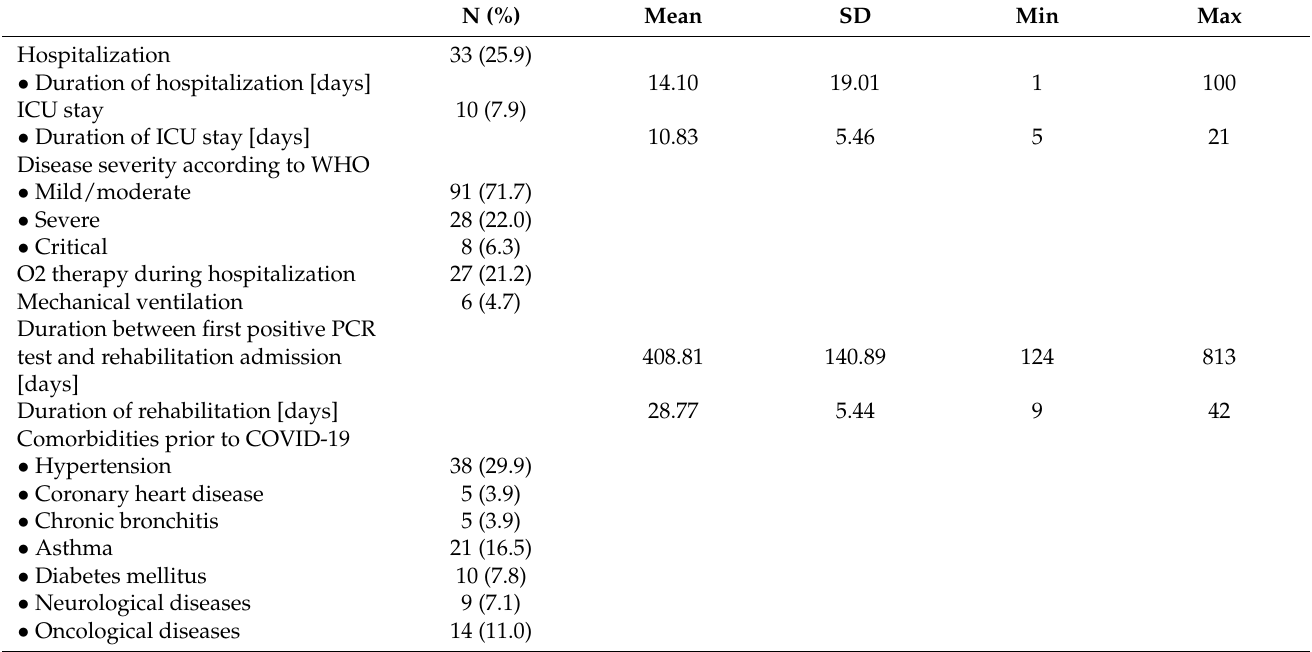
Table 2. Course of COVID-19 disease and comorbidities prior to COVID-19. N (%) Mean SD Min